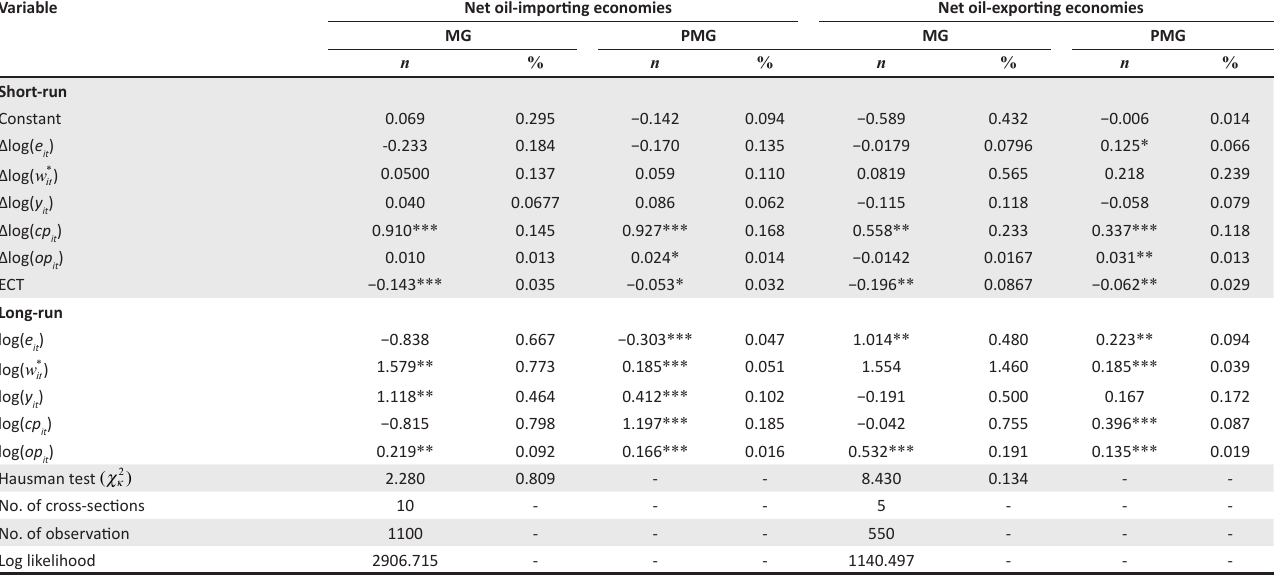
TABLE 2: Exchange rate pass-through panel regression results (symmetric model without interaction term). Variable Net oil-importing